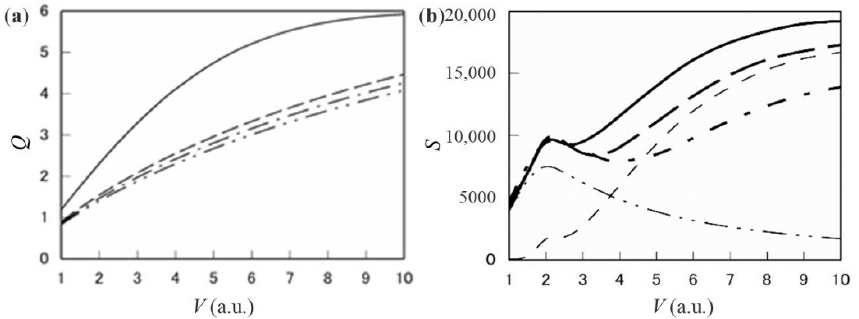
Figure 22. ( a ) Average charge per atom and ( b ) electronic stopping power of carbon for a C 60 fullerene at speed V to 10 v 0 . (left) The solid line, the dot-dot-dashed line, dot-dashed line, and dashed lines refer to a single C ion, a C 60 with cluster radius of R cl = 6.6 a 0 , R cl = 8 a 0 , and R cl = 10 a 0 , respectively. (right) The solid line, the long dashed line, and the dot-dashed line refer to the case of R cl = 6.6 a 0 , R cl = 8 a 0 , and R cl = 10 a 0 , respectively [53].